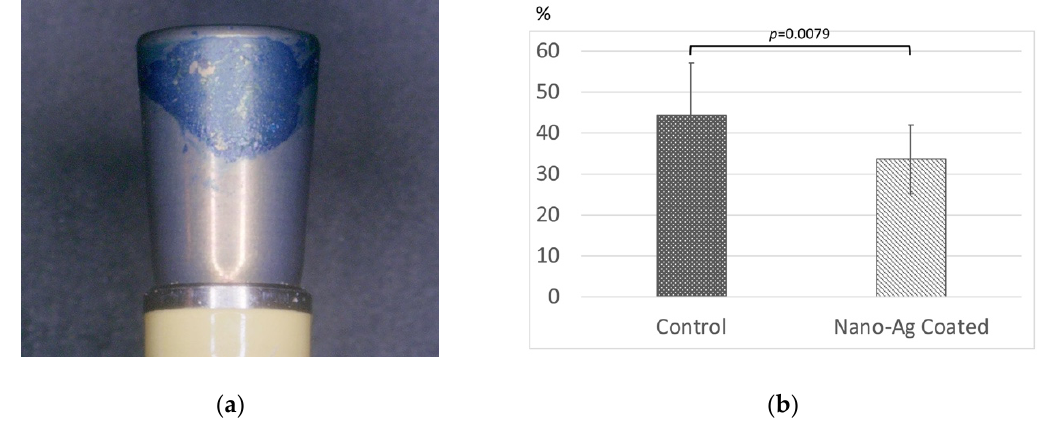
Figure 7. The plaque-covered area of healing abutment: ( a ) the image after staining with methylene blue disclosing solution; ( b ) the percentage of plaque-stained area to the axial surface of implant abutment. Error bars represent mean ± standard deviation for n = 17. One-way analysis of variance and t -test comparisons were used for parametric analyses. There was a statistically significant difference between control and nano-Ag coating.